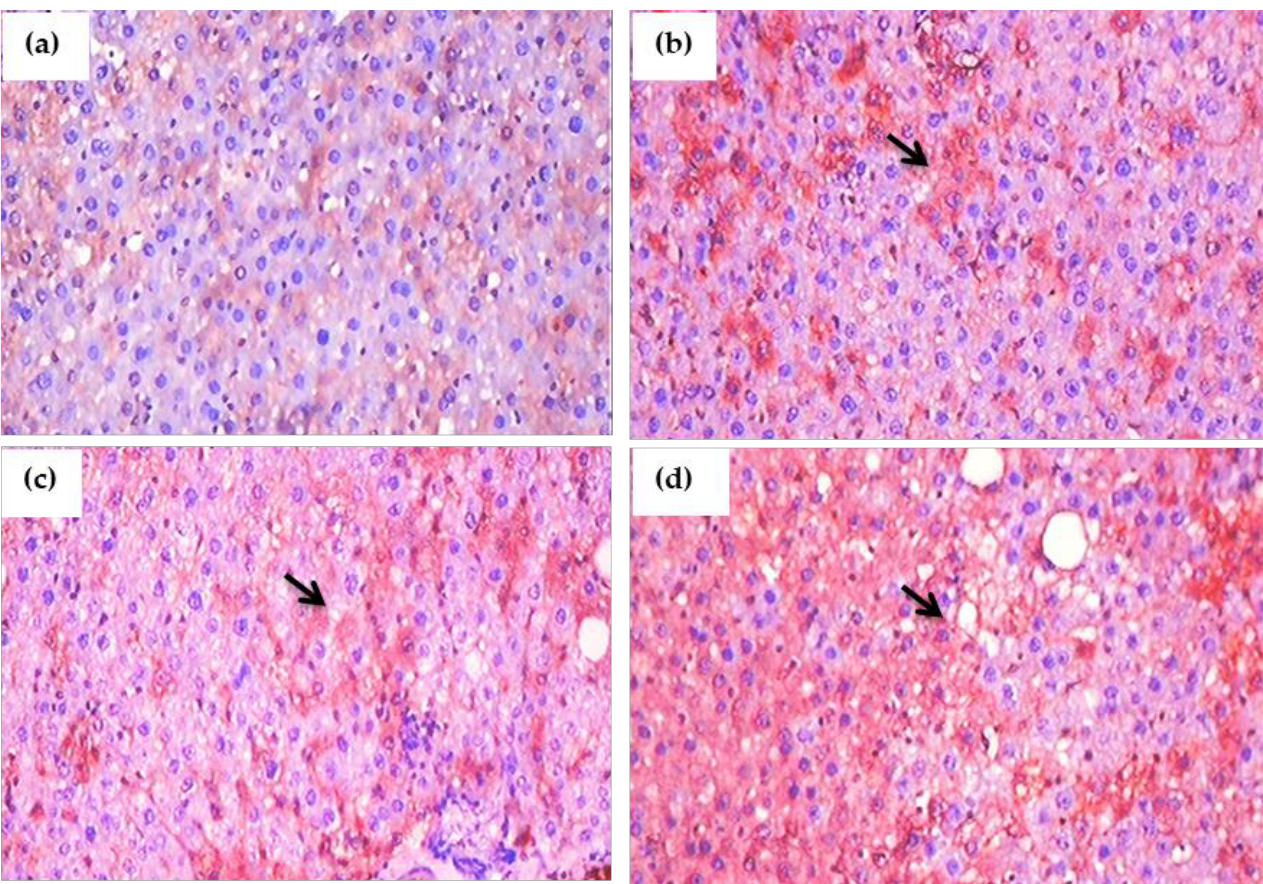
Figure 11. ( a – d ): Immunohistochemical evaluation of the effect of glyphosate on IL-6 protein expression in the liver sections of experimental rats. This image depicts typical IHC photomicrographs (100 × magnification) of IL-6 staining intensity (black arrows) in the liver tissues of experimental group. ( a ) Normal control rats showing small and large diameter hepatocytes; ( b ) glyphosate-treated rats (50 mg/kg b.wt.) showed IL-6 expression with mild hydropic degeneration of hepatocytes; ( c ) glyphosate-treated rats (100 mg/kg b.wt.) showed elevated expression of IL-6 with moderate hydropic degeneration and focal necrosis; and ( d ) glyphosate-treated rats (250 mg/kg b.wt.) showed increased expression of IL-6 with high level of hydropic degeneration and focal necrosis when compared to control